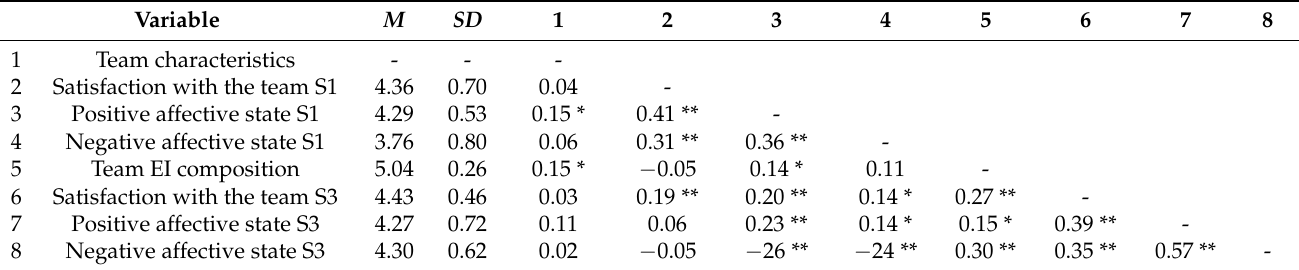
Table 1. Descriptive statistics and correlations for the study variables in control condition: Teams without